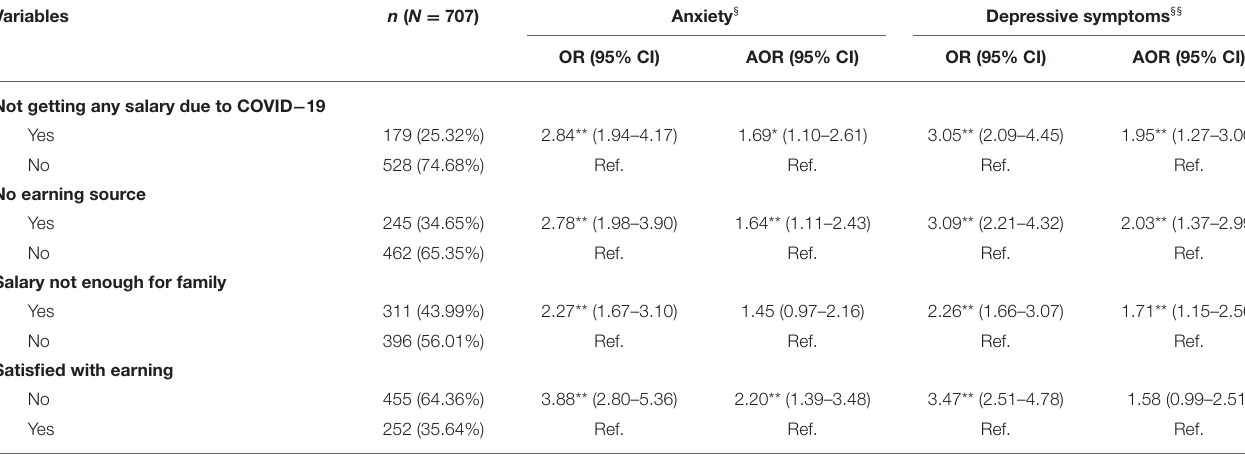
TABLE 2 | Association among current financial situation, anxiety and depressive symptoms among adult wage earners in Bangladesh.